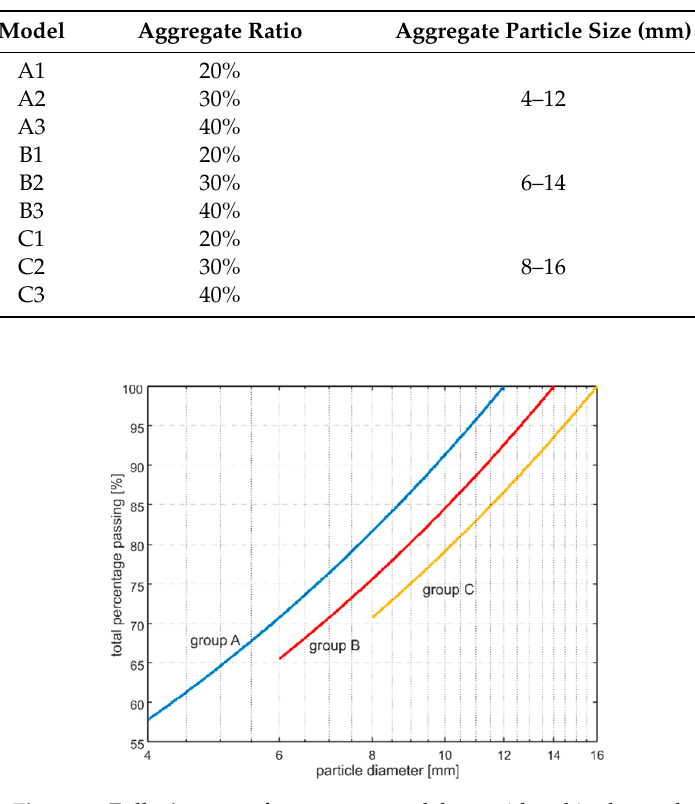
Figure 6. Geometry of numerical models varying in aggregate ratio: ( a ) Model A1, ( b ) model A2, and ( c ) model A3. 3.4.2. Excitation Function The excitation function was in the form of a windowed tone burst, which is commonly used in Lamb wave-based inspections [26]. The tone burst is a modulated sine or cosine function by the Hann or Gaussian window. The modulation allows the dispersion effect to be reduced and provides the mode purity [26]. In this study, the five-cycle sine function with carrier frequencies of 25, 50, 100, and 150 kHz modulated by the Hann window was used. In the numerical model, the excitation was applied as a concentrated time-dependent force. As, in the actual cases, the actuators and sensors are usually attached at the surface of the plate, the excitation was applied perpendicularly to the plate surface. The signals were registered at the series of positions spaced 1 mm apart along the propagation path with a length of 49.5 cm.